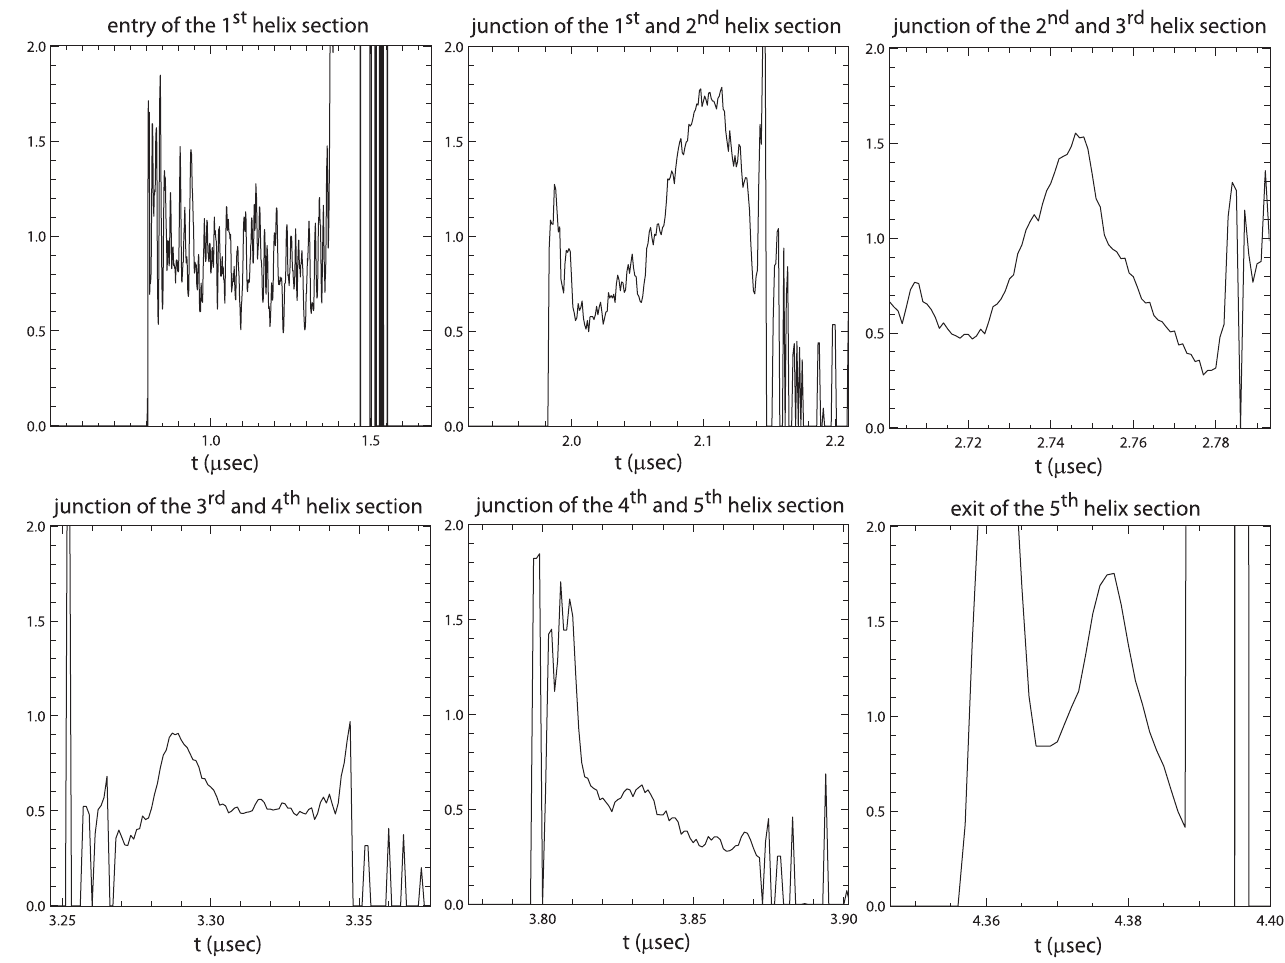
FIG. 14. The (cid:1) p=p (in 10 (cid:1) 3 ) of the ion beam versus time at varies positions outside the